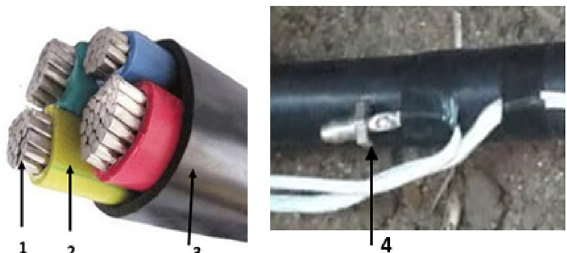
Fig. 4 Construction of the proposed cable: 1-aluminum conductor, 2-XLPE insulation, 3-PVC outer sheath, and 4-Thermocouple installation